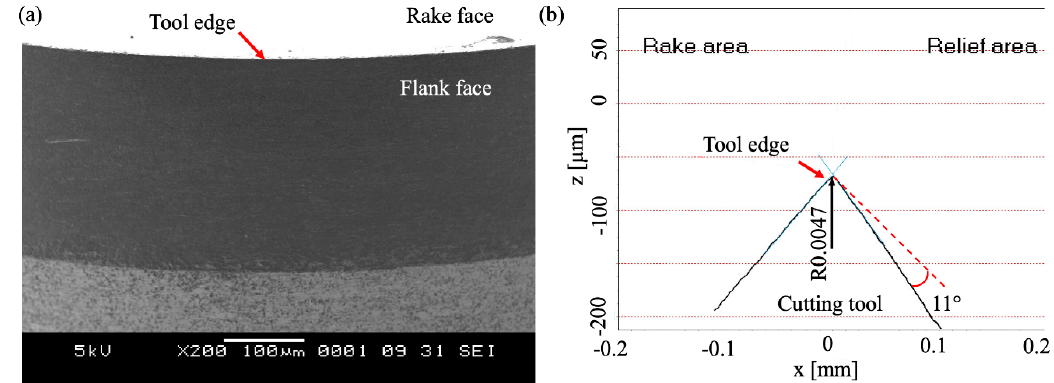
Figure 2. ( a ) Scanning electron microscopic (SEM) image of the as received cutting tool edge; and ( b ) the tool edge radius measurement using a MikroCAD 3D optical imaging system. ( b ) the tool edge radius measurement using a MikroCAD 3D optical imaging